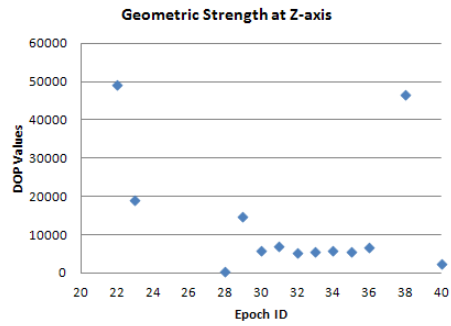
Figure 6. Geometric strength at Z for epoch